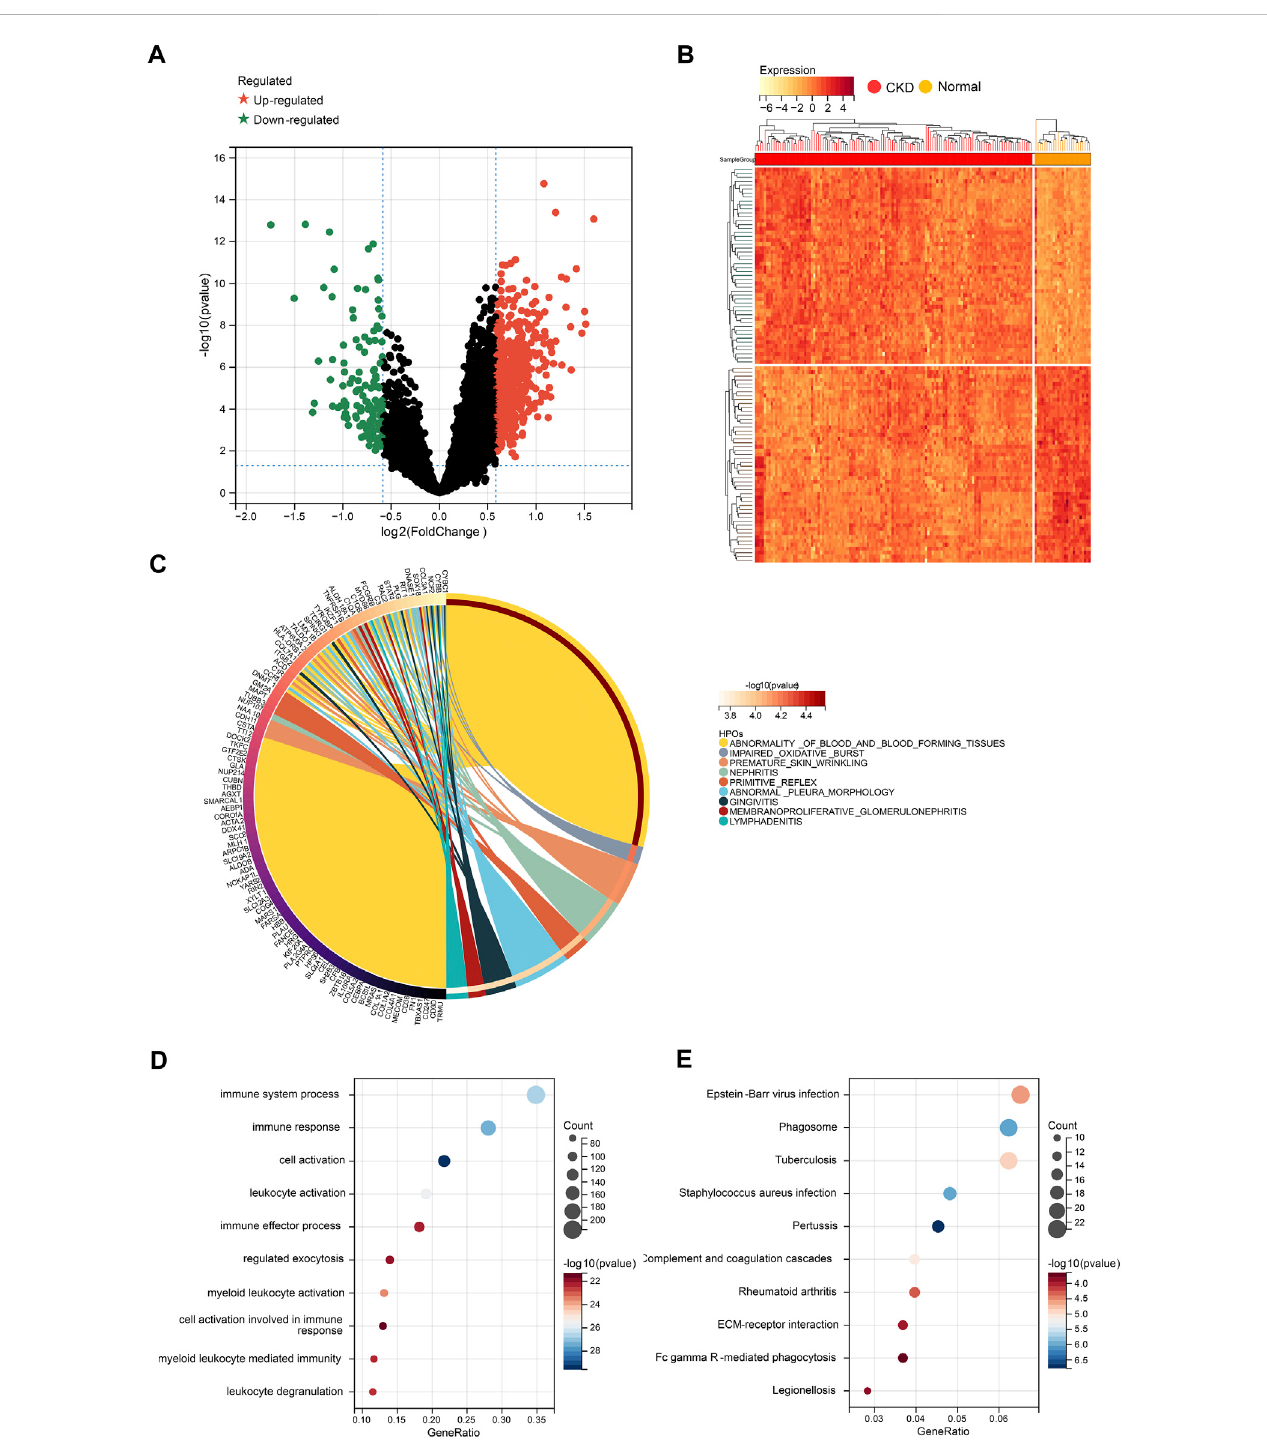
FIGURE 3 Identi fi cation of DEGs for CKD. (A) Volcano plots showing DEGs between CKD and normal group. (B) Cluster heatmap showing the top 50 signi fi cantly upregulated DEGs and the top 50 signi fi cantly down-regulated DEGs. (C) Top 20 of Human phenotype Ontology analysis. (D) Top 20 of GO biological processes analysis. (E) Top 20 of KEGG pathway